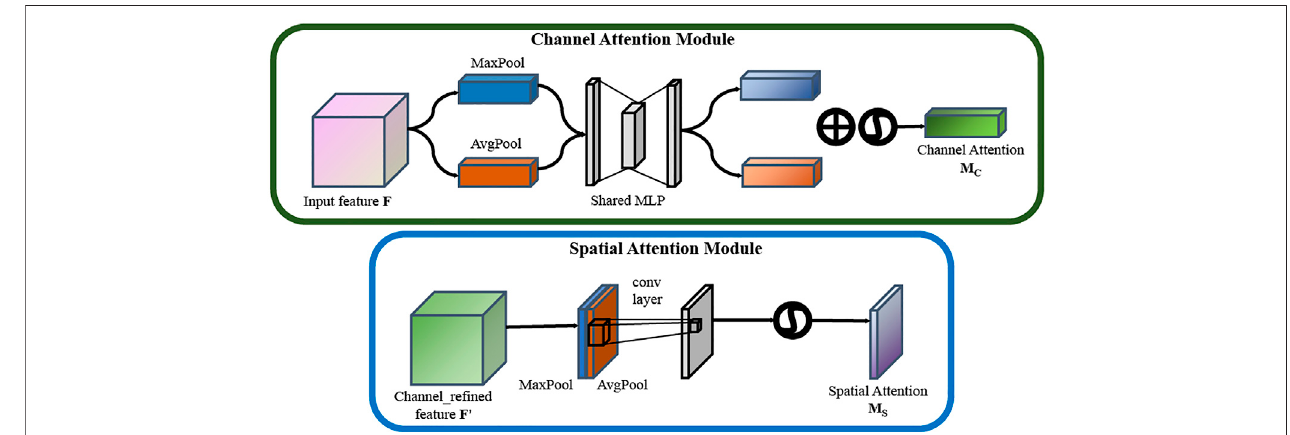
FIGURE 3 | Diagram of each attention sub-module (Woo et al., 2018).